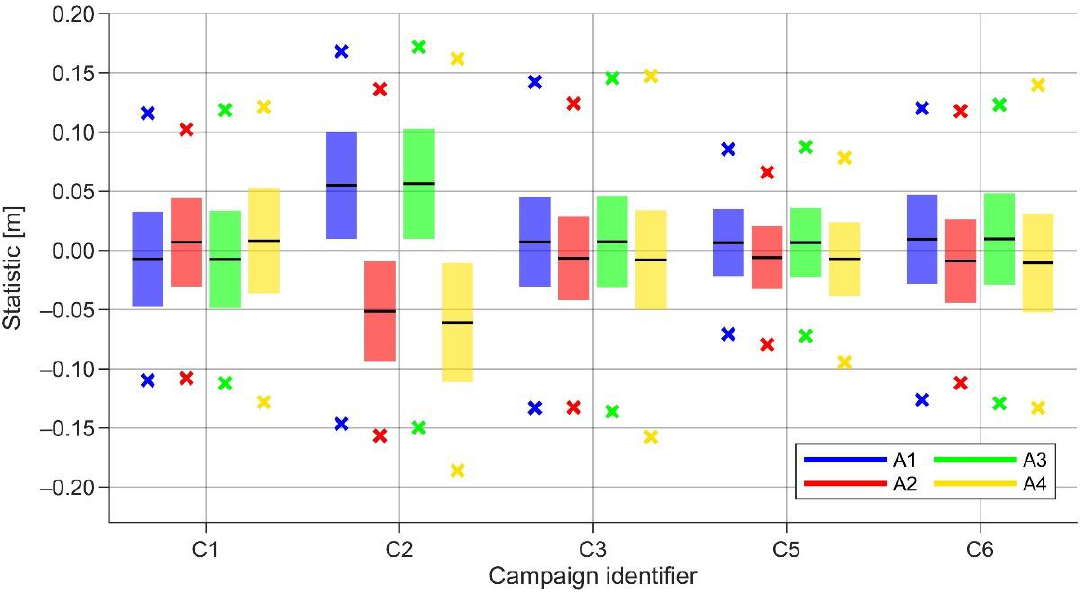
Figure 8. Statistical properties of discrepancies 𝑑 𝐴𝜉 for antennas A1 – A4. The black lines are mean values, and colored bars denote standard deviation estimates. Crosses show 99th percentile minimum and maximum discrepancies.